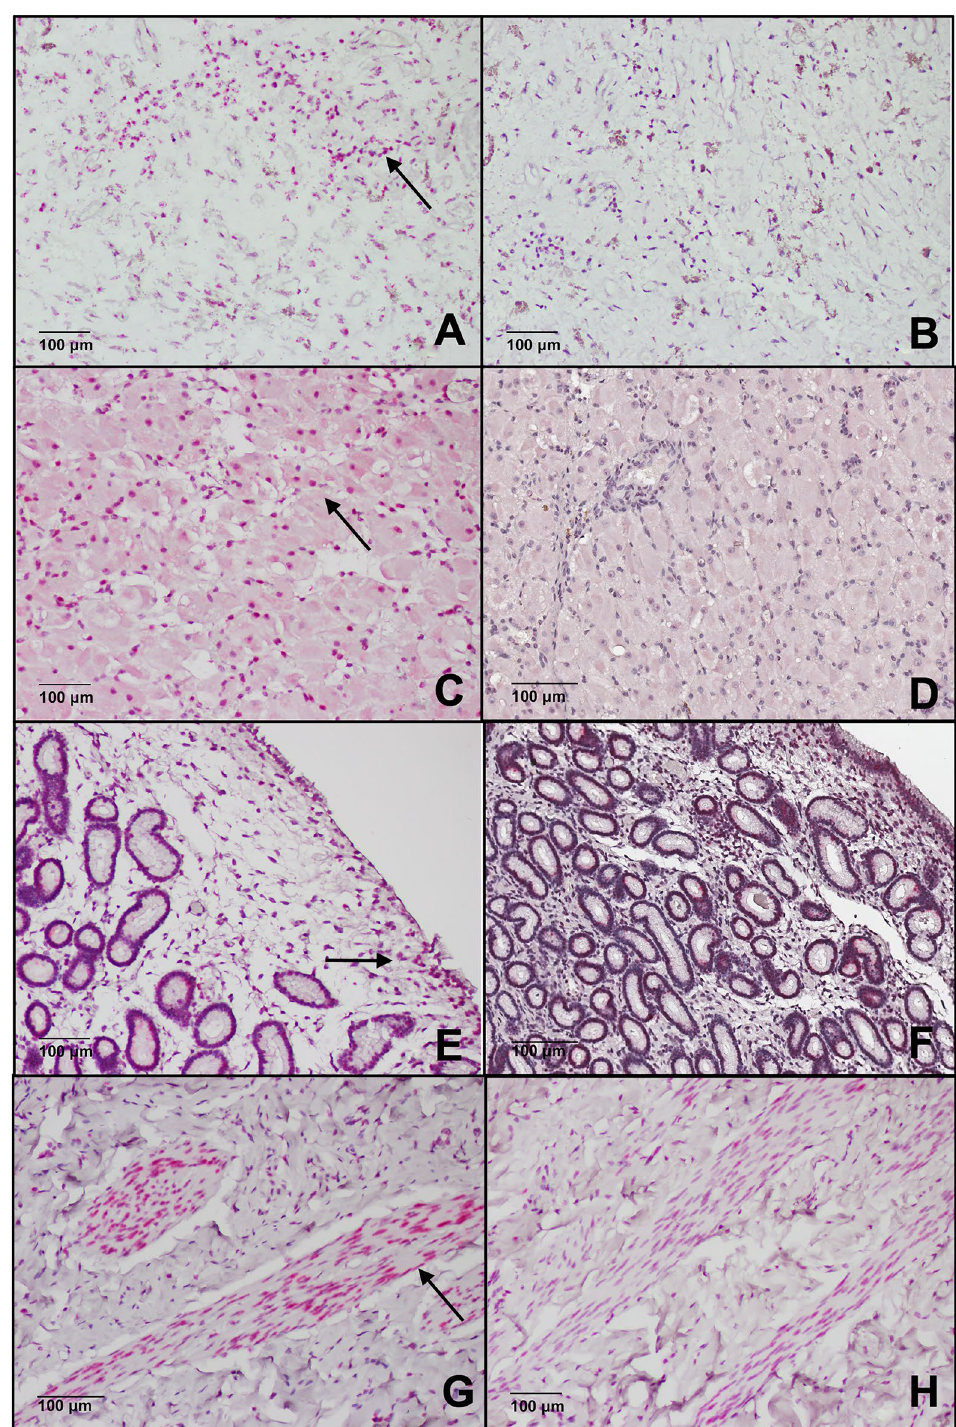
Figure 8. Photomicrograph demonstrating mRNA expression of OXT (pink dots) in: ( A ) posterior hypophysis, ( C ) corpus luteum, endometrium ( E ) and myometrium ( H ). Black arrow shows specific staining. Control DAB for each tissue ( B , D , F and H